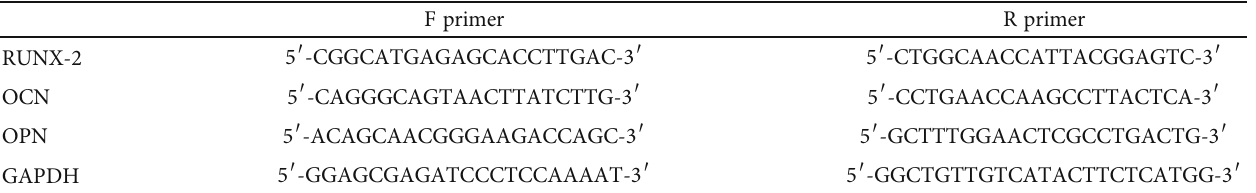
Table 1: Primer information of